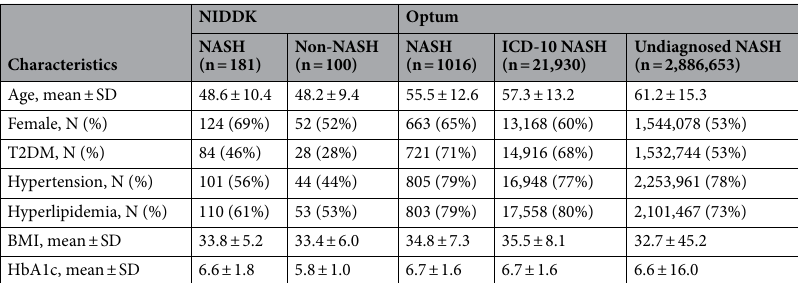
Table 1. Clinical characteristics of study cohorts by clinical status. NIDDK: National Institute of Diabetes and Digestive Kidney Diseases; NASH: biopsy-confirmed NASH; Non-NASH: biopsy-confirmed non-NASH; ICD-10 NASH: patient coded for NASH, no biopsy reading; undiagnosed NASH: patients with no records of NASH by coding or liver biopsy; T2DM: type 2 diabetes mellitus; BMI: body mass index; HbA1c: glycated hemoglobin.